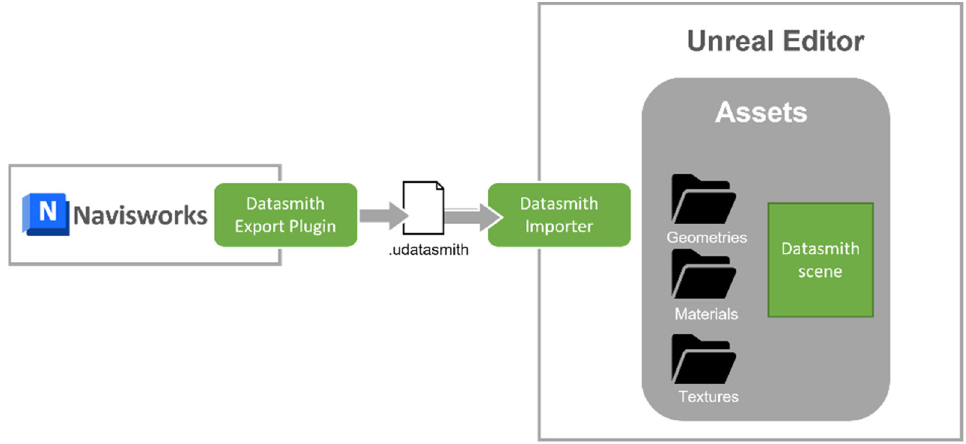
Figure 6. Datasmith workflow.